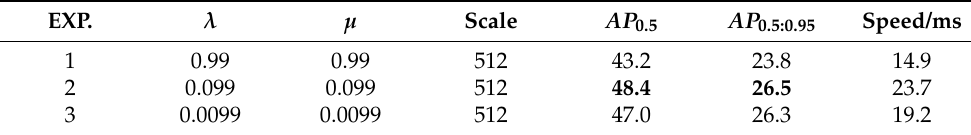
Table 6. The ablation study of the trade-off parameter. The best results are in bold. EXP. λ µ Scale AP 0.5 AP